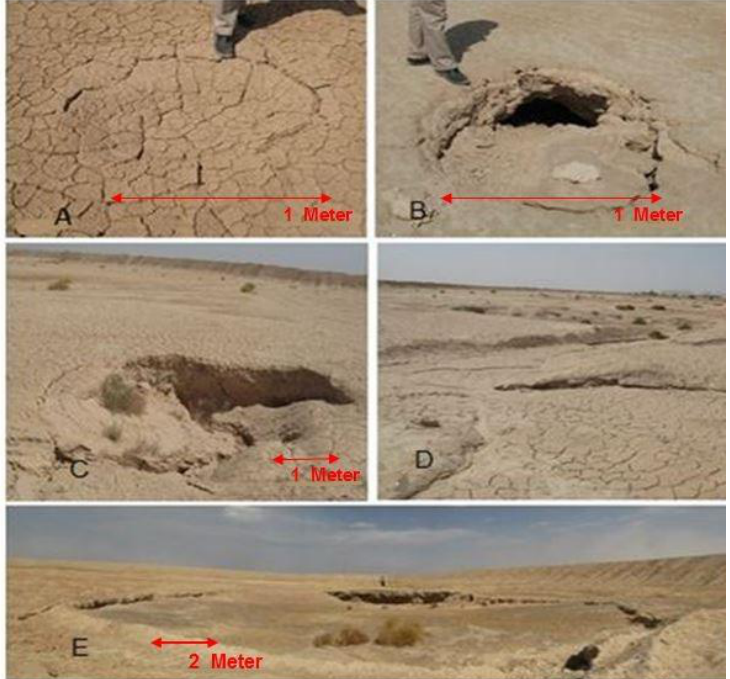
Figure 7. The process of occurring of sinkholes near Feizabad. ( A ) concentration of surface waters and centralized subsidence; ( B ) forming of a devastating hole; ( C ) development of the cavity and the transfer of more surface material to the depths part; ( D ) subsidence and expanding the e ff ective range on the main cavity; ( E ) collapse and occurrence of the